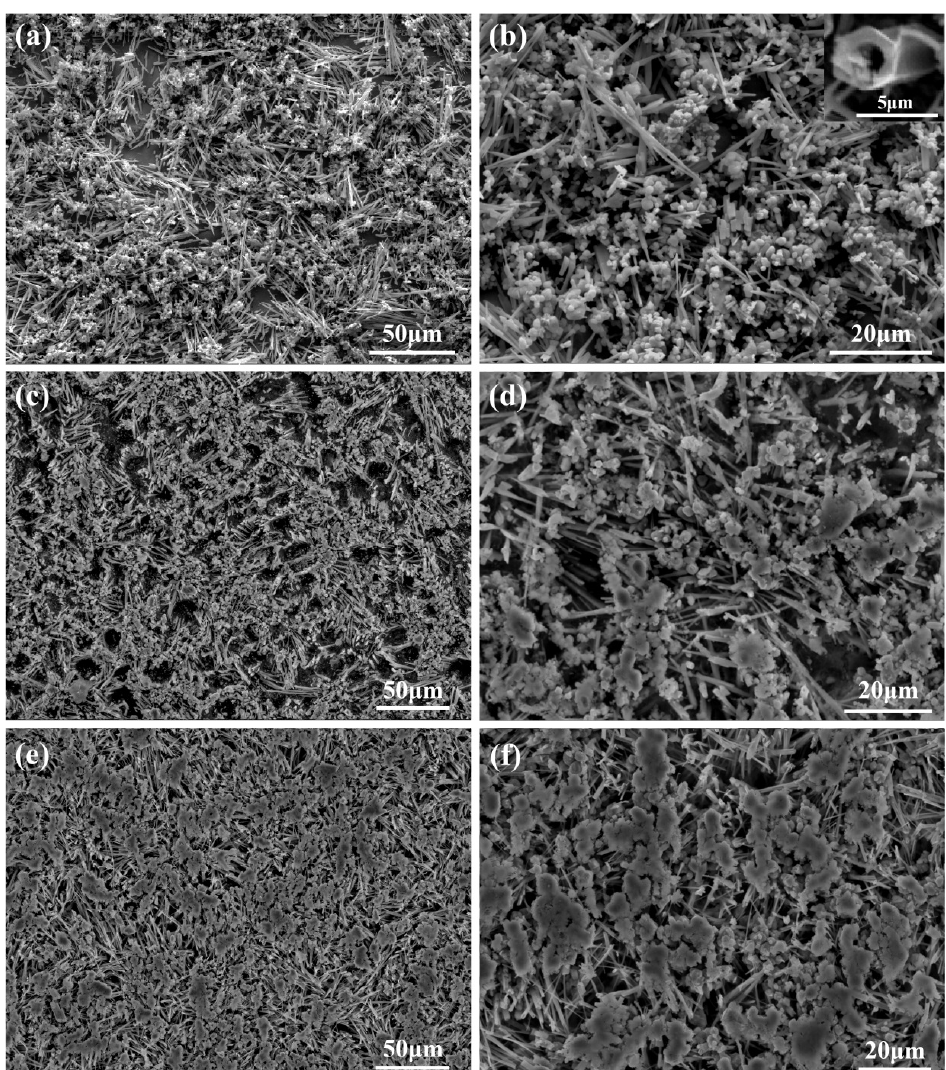
Figure 5. Microstructures of the deeply etching composites prepared by adding Ti–SiC with different contents. ( a , b ) Cu ‐ 4.86Ti ‐ 1Si ‐ 0.43C; ( c , d ) Cu ‐ 6.8Ti ‐ 1.4Si ‐ 0.6C; ( e , f ) Cu ‐ 9.72Ti ‐ 2Si ‐ 0.86C.